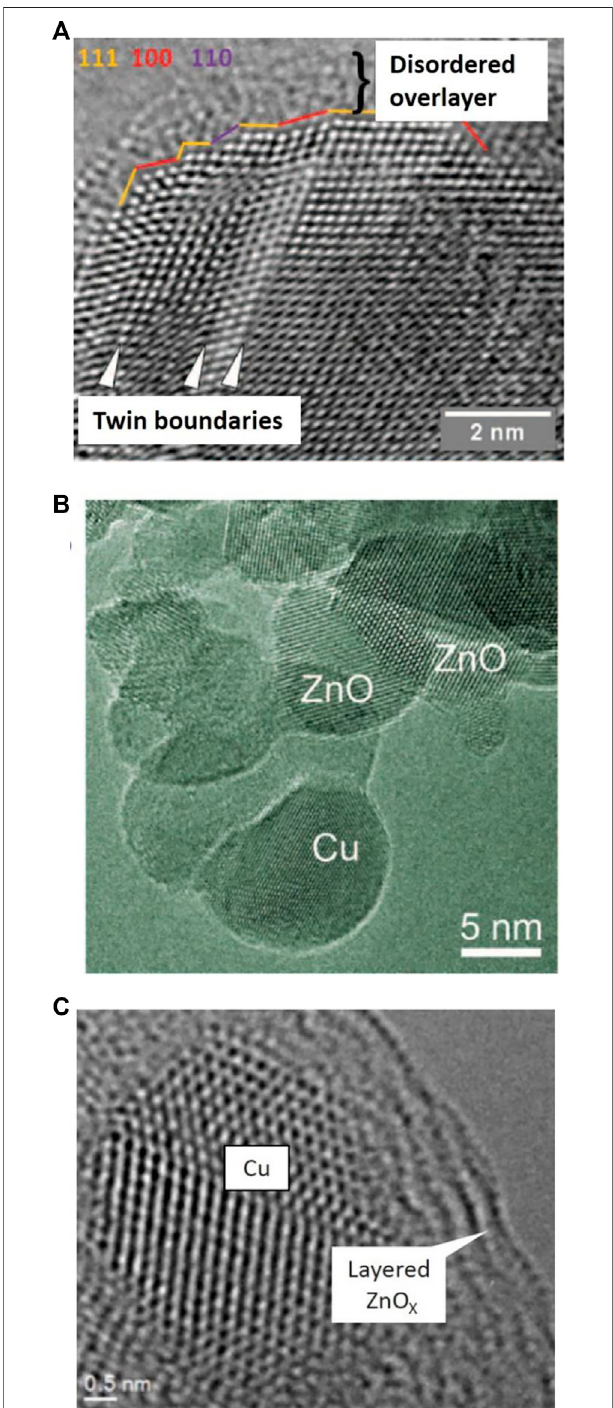
FIGURE 8 | (A) Aberration-corrected HRTEM images of Cu particles in the conventionally prepared, most-active Cu/ZnO/Al 2 O 3 catalyst (Behrens et al., 2012). (B) Promoting effect of ZnO on Cu catalysts for methanol synthesis (Kuld et al., 2016). (C) Formation of a ZnO overlayer in